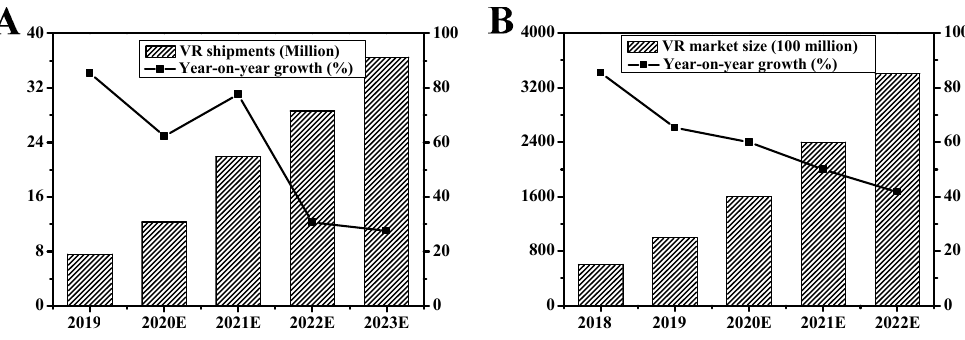
Figure 9. ( A , B ) Global VR headset shipments and market size changes. Figure 9. ( A-B ) Global VR headset shipments and market size changes.